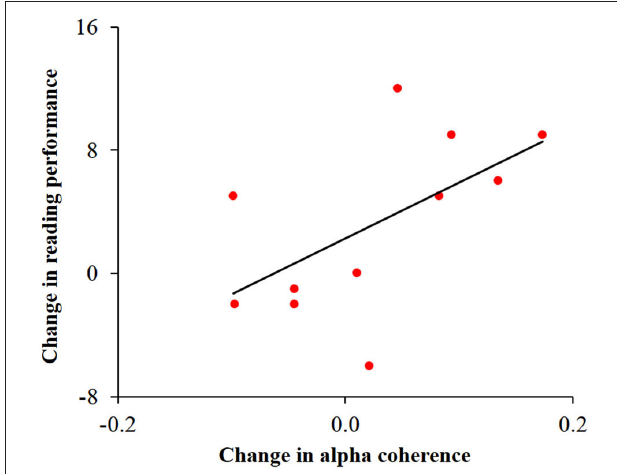
FIGURE 5 | Correlation between change in temporal alpha coherence and change in reading performance in the dyslexic group . Change in alpha coherence, calculated by the subtraction of pre- from post-training, was positively correlated with the change in number of words read correctly in 30 s ( r = 0.58, p <